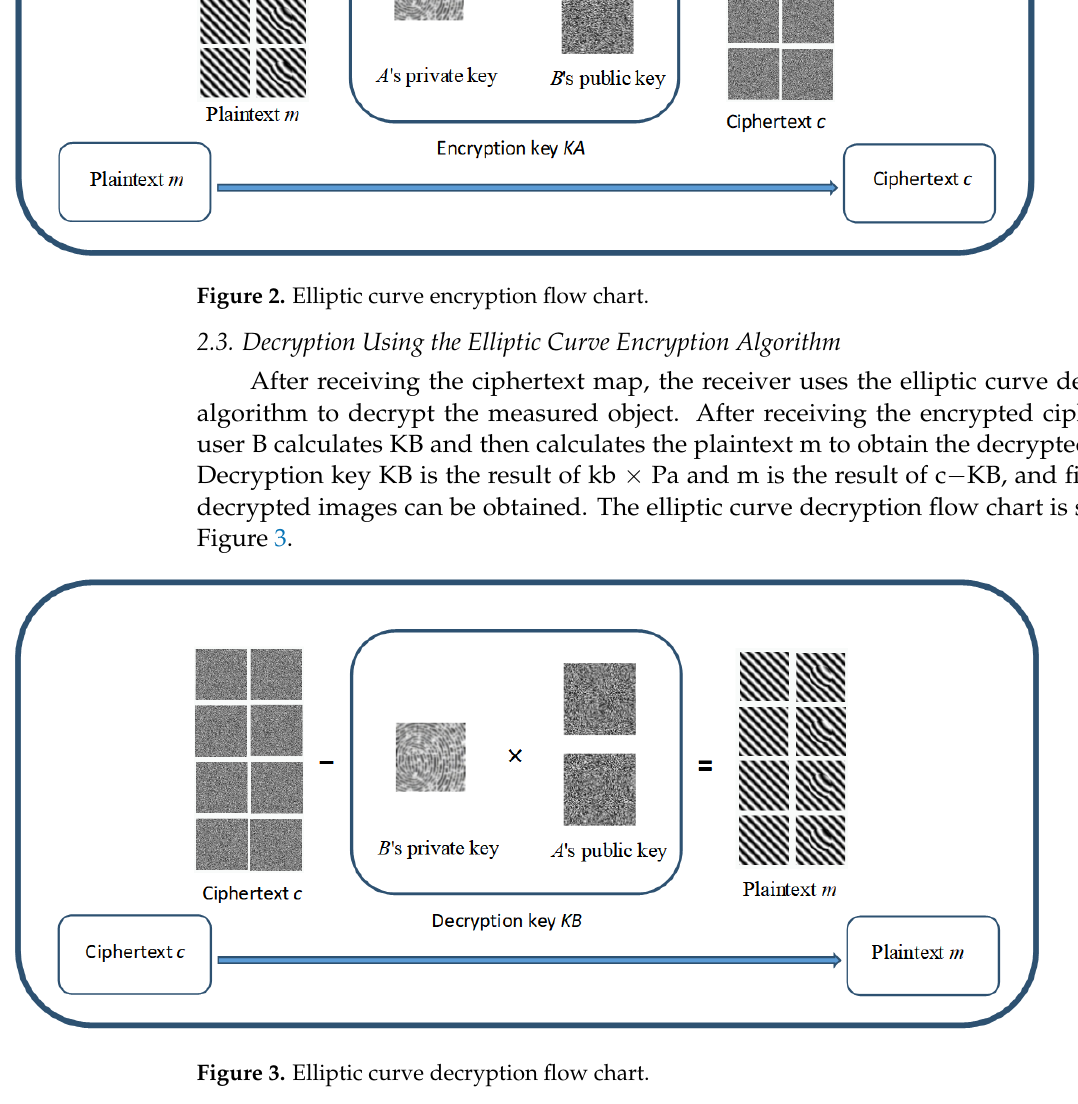
Figure 3. Elliptic curve decryption flow chart.